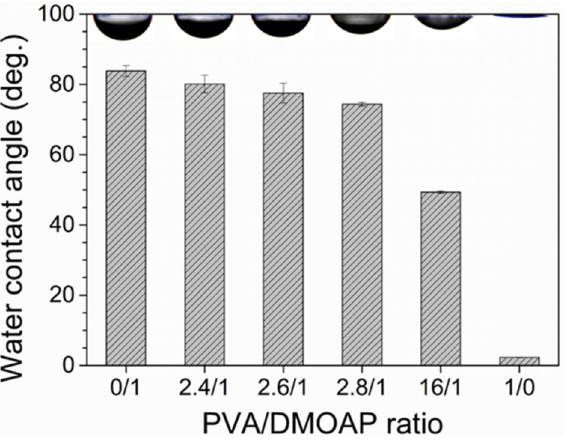
Figure 3. Water contact angle measured on glass substrates coated with the PVA/DMOAP composite. Glass substrates were coated with PVA/DMOAP mixtures of various mass ratios (0:1, 2.4:1, 2.6:1, 2.8:1, 16:1 and 1:0) and subjected to water contact angle measurements. Representative images of the water droplet at each PVA/DMOAP mass ratio are shown at the top of the chart. Error bars represent standard deviations calculated from at least three independent